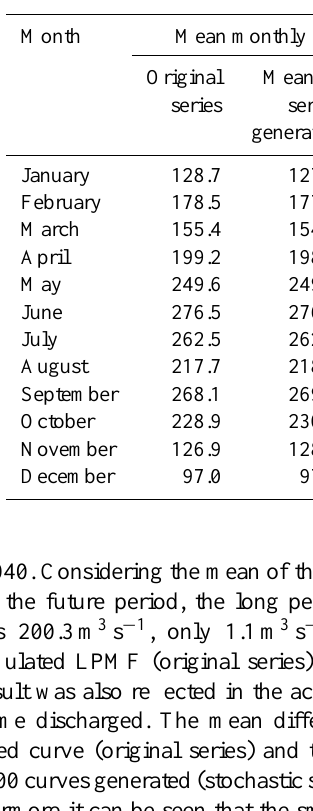
Table 2. Difference between the original series (simulated) and the 1000 stochastic series generated – mean flow and monthly standard deviation in the period between 2011 and 2040, Santo Ângelo gauge station.